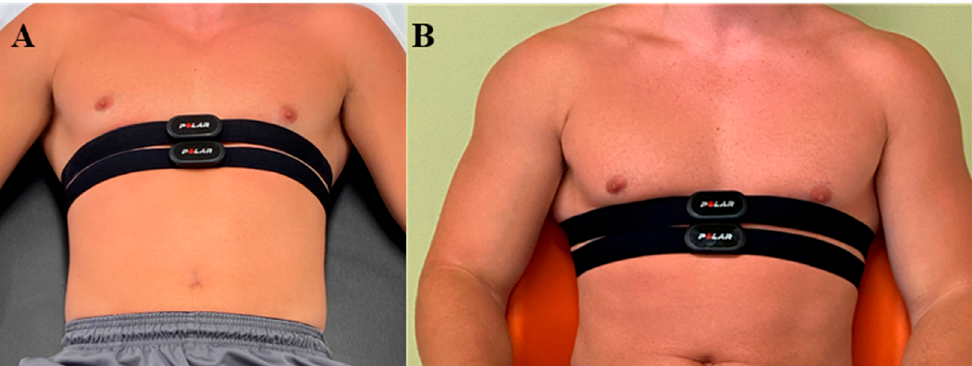
Figure 1. Configuration of Polar H10 heart rate monitors in the supine ( A ) and seated ( B )